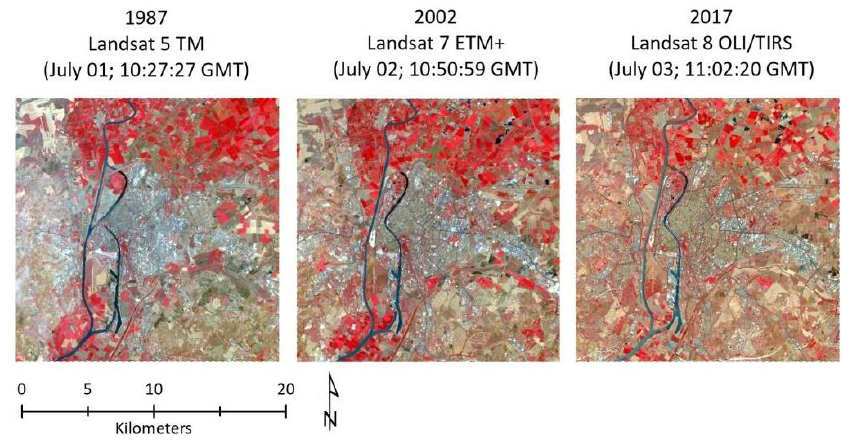
Figure 2. Landsat images used in this study displayed in a false color composite (htttp://glovis.usgs.gov).